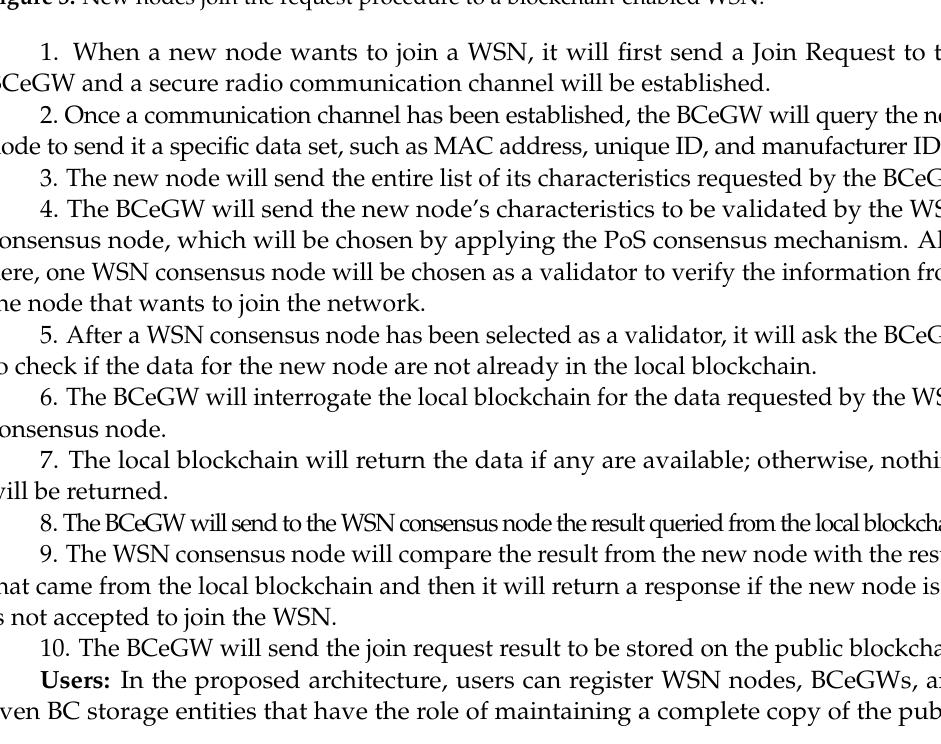
Figure 3. New nodes join the request procedure to a blockchain-enabled WSN.